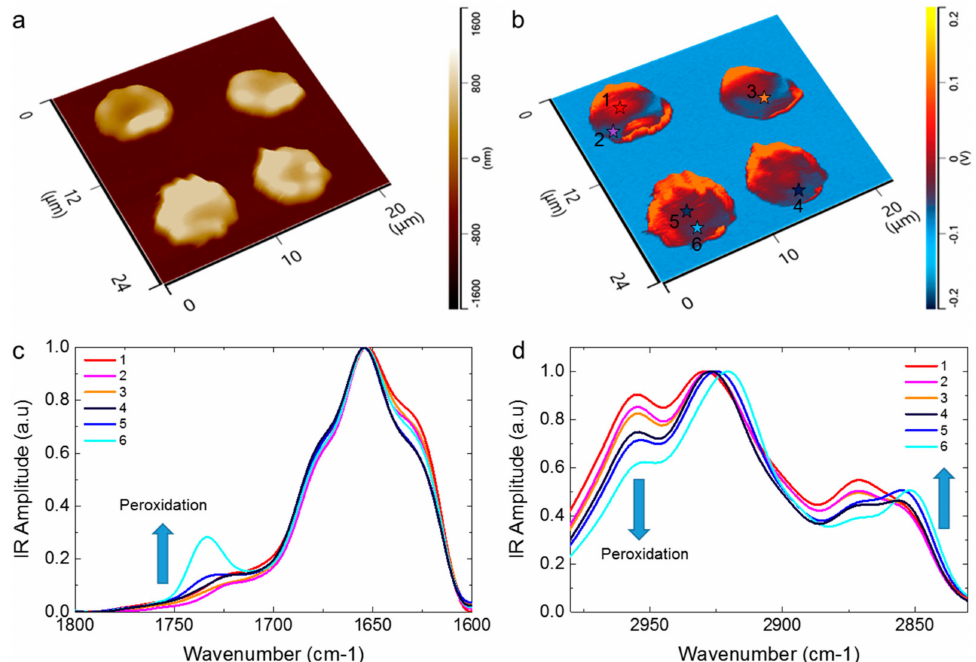
Figure 4. Membrane peroxidation of RBCs. 3-D ( a ) morphology and ( b ) IR absorption maps of the cells, where the dark region of the cell shows sign of oxidative stress. Average, smoothed and normalised spectra whose position is indicated by the coloured stars in the map (spectra from 6 positions, each one derived from the average of 5 independent spectra, n = 30) acquired in the spectroscopic ( c ) protein and ( d ) lipid regions for bright (1–3) and dark (4–6) regions of absorption within the cells. The ratio of methylene and methyl stretching directly correlate with the appearance of the ester C=O band, due to membrane